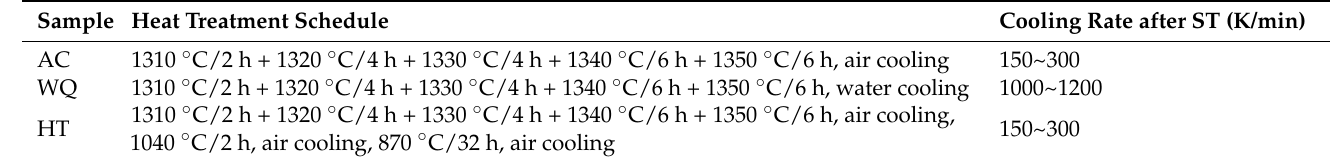
Table 2. Heat treatment schedule of experimental alloy under different cooling